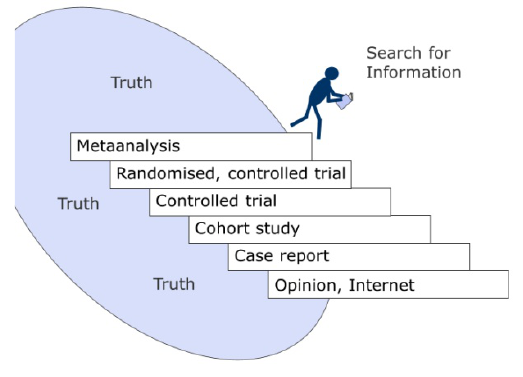
Pyramid of evidence* Staircase of